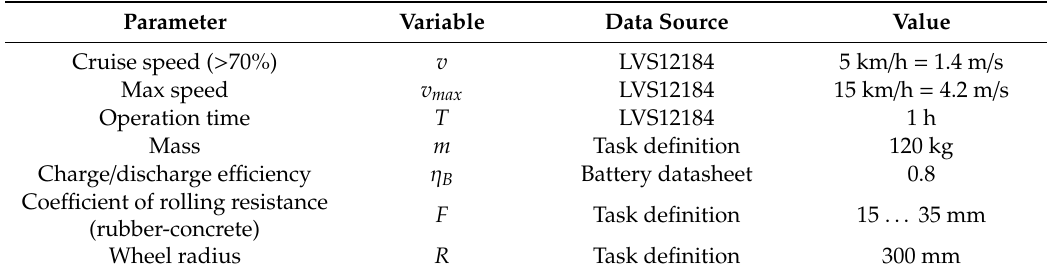
Table 1. Operation parameters of the